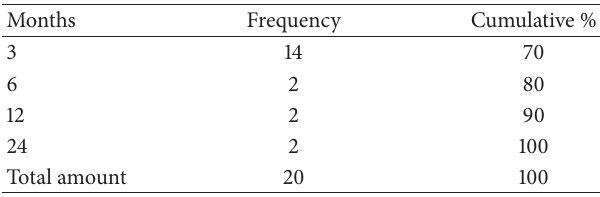
Table 3: Point in time (months) of OKM grade D (no